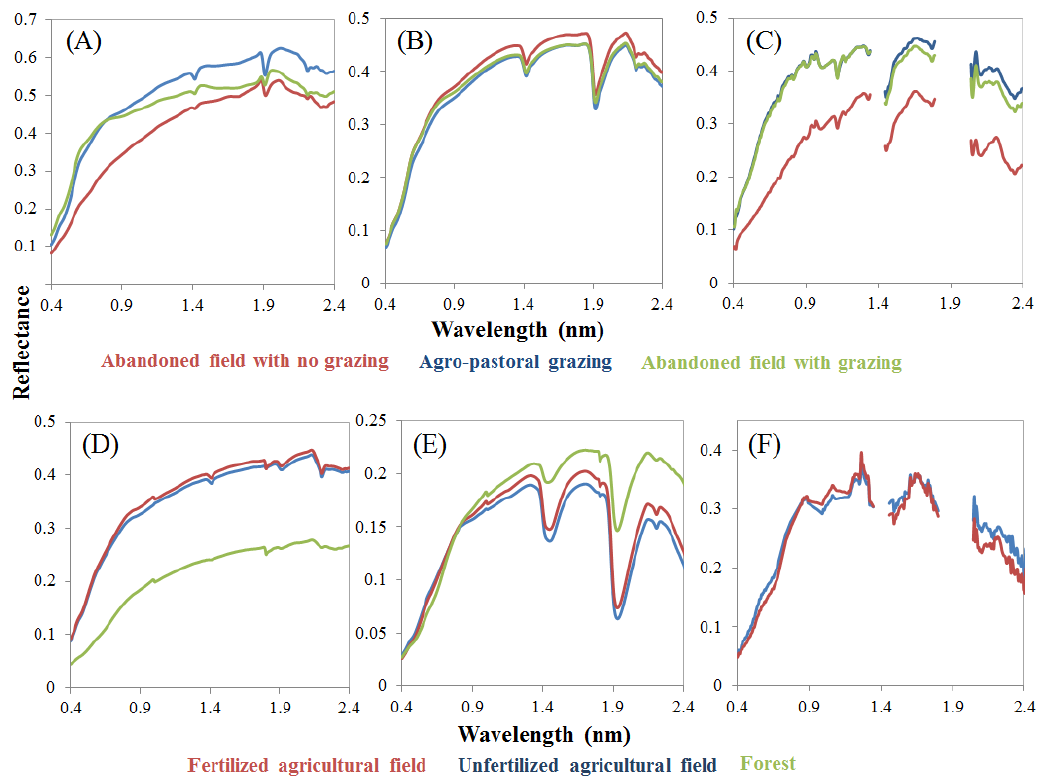
Figure 3. The average spectral signatures of the two study sites: Migda, Israel ( A , B , C ) and Schäfertal, Germany ( D , E , F ). The spectral dataset included: (A and D) laboratory spectral signatures; (B and E) field spectral signatures; and (C and F) airborne imaging spectral signatures. The land-use classes are characterized by the different